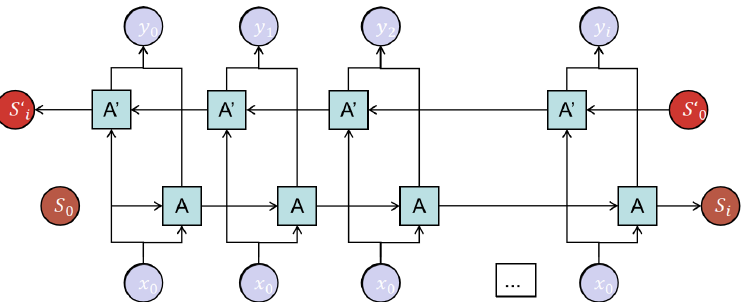
Figure 9. Bidirectional LSTM structure.